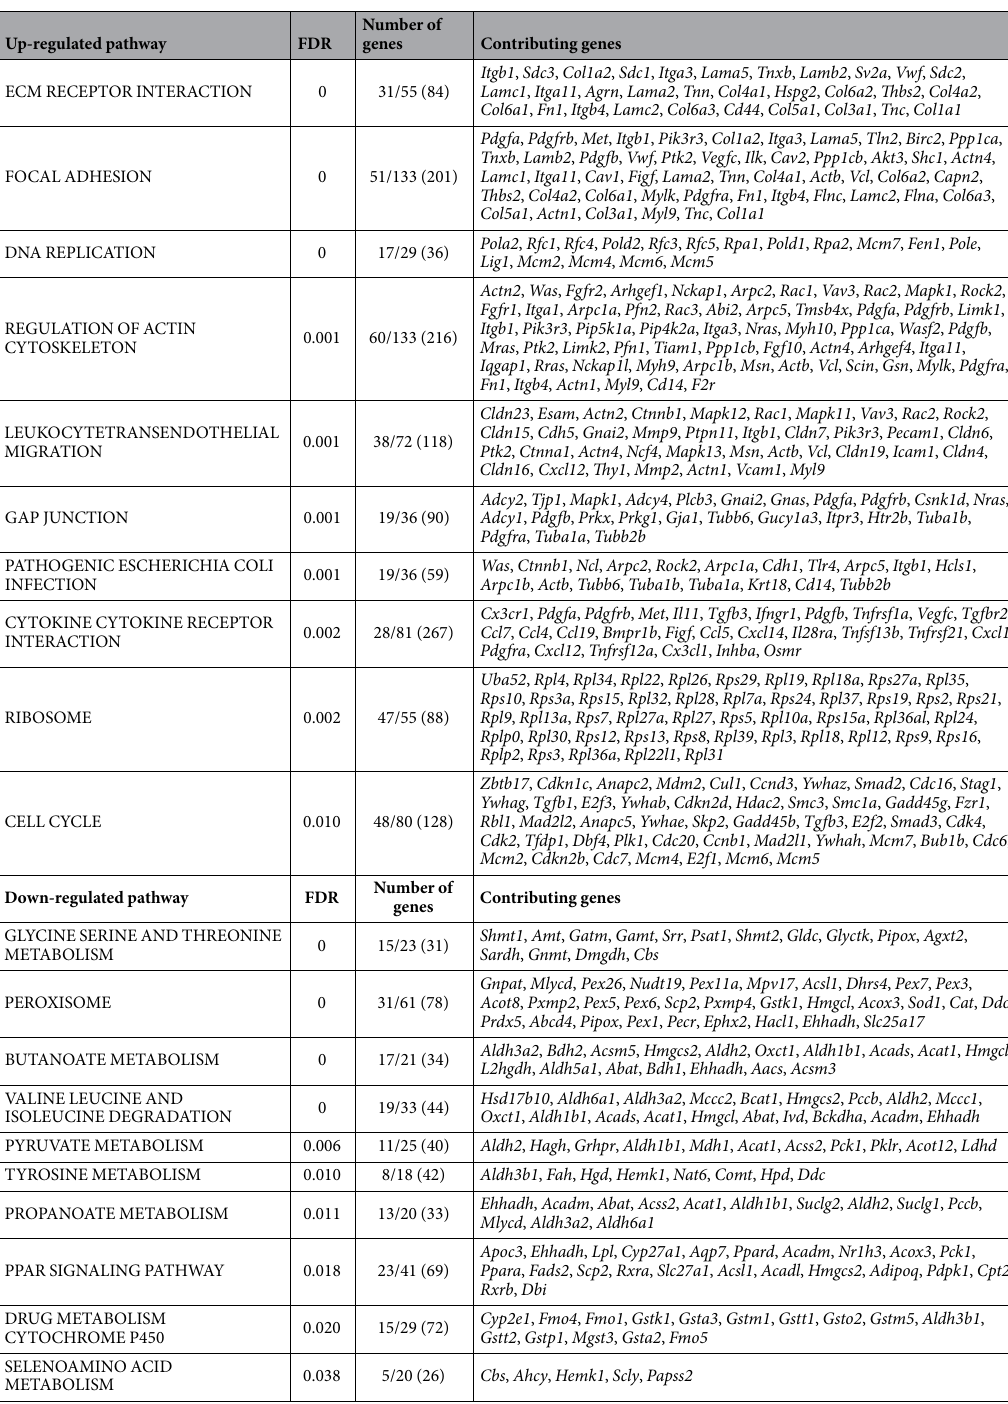
Table 3. List of the top 10 KEGG pathways up- or down-regulated in 1 month-old female Tg Umod C147W mice relative to age- and sex-matched Tg Umod wt . FDR, False Discovery Rate. Number of genes, A/B (C): A, number of genes contributing to pathway enrichment; B, number of genes from the KEGG pathway expressed in analysed experimental groups; C, total number of genes listed in the KEGG